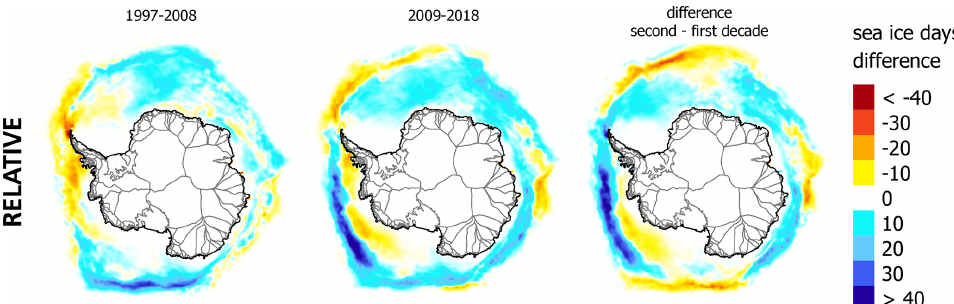
Figure 4. Difference in the number of sea ice days per year (during the sea ice season from April to October) compared to the reference mean (1982–1996) and the difference in sea ice cover duration between both